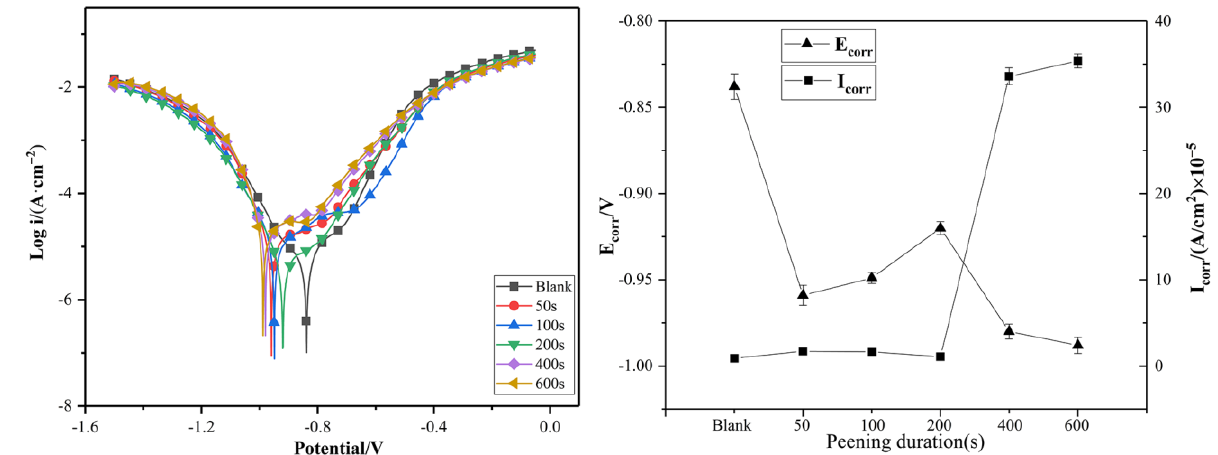
Table 5. The parameters of the equivalent elements in the equivalent circuit of the samples with different lengths of USP time.